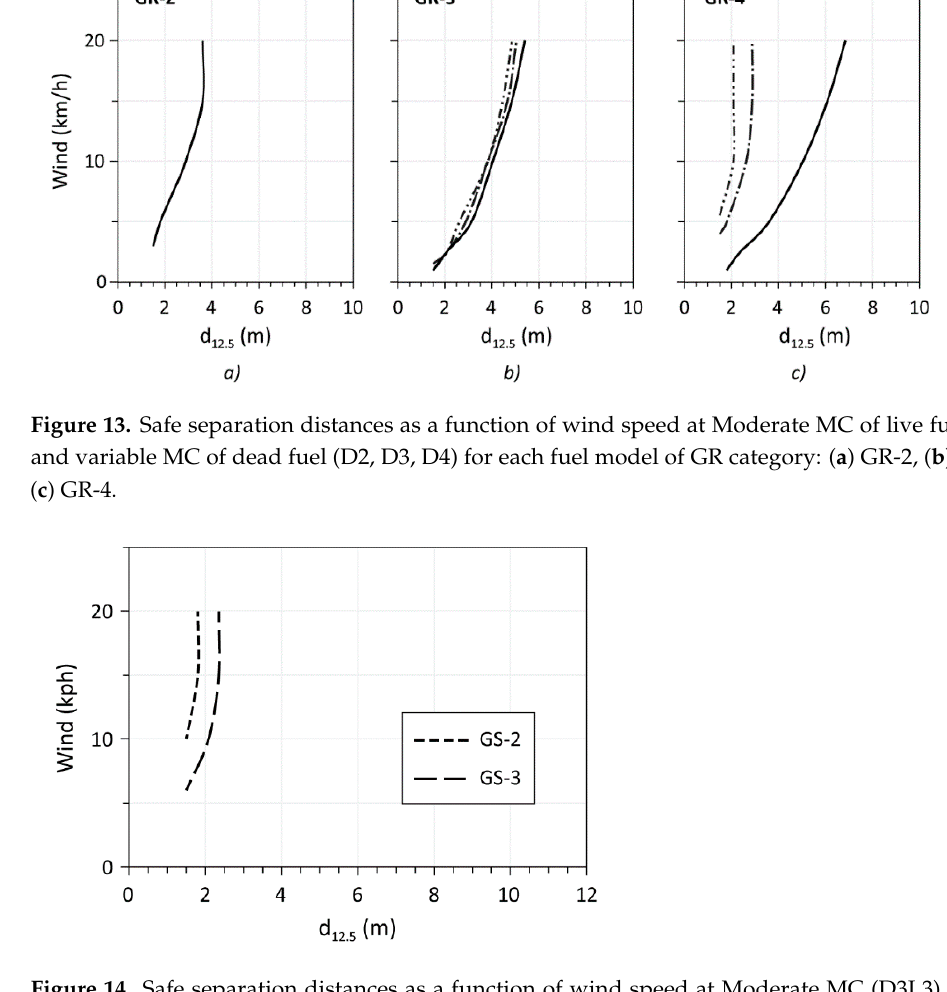
Figure 14. Safe separation distances as a function of wind speed at Moderate MC (D3L3) for GS fuel models.